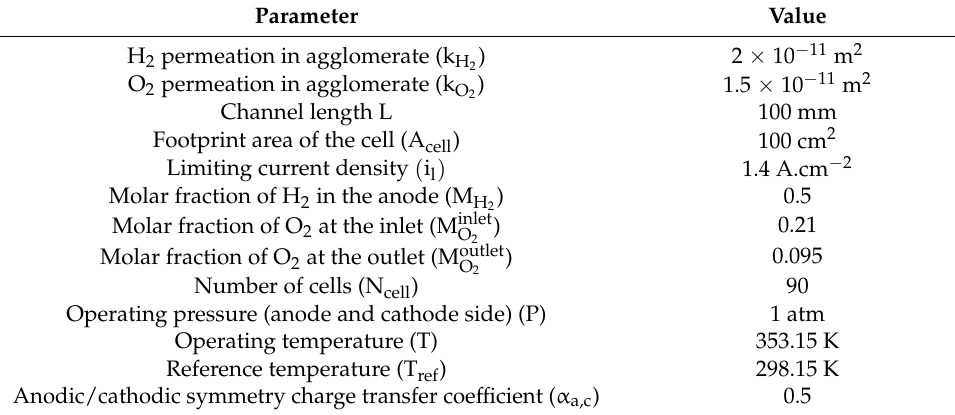
Table 1. Input parameters for PEMFC numerical modeling [40,41].